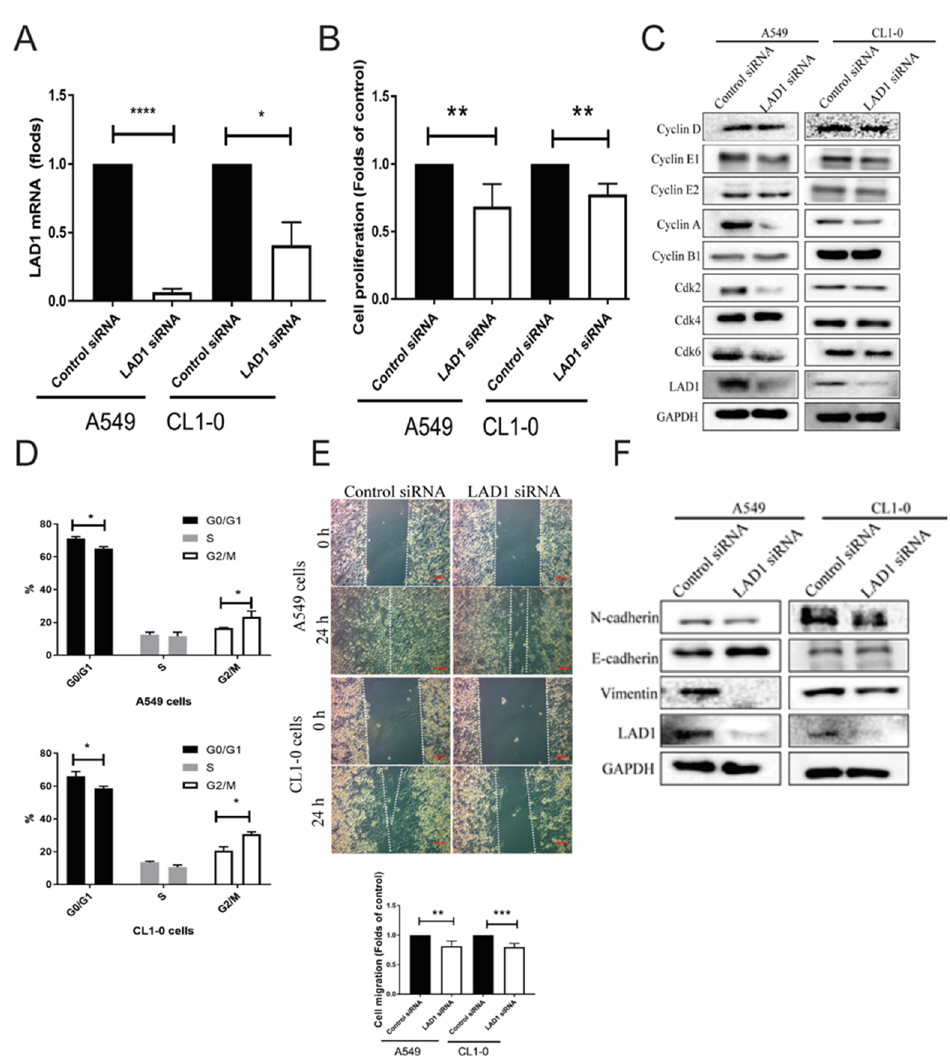
Figure 7. Functional analysis of LAD1 in LUAD. ( A ) Knockdown efficiency of LAD1 via siRNA method. ( B ) Cell proliferation is counted when LAD1 expression was downregulated with in A549 and CL1-0 LUAD cancer cell lines. ( C ) Cell cycle associated proteins are analyzed by Western blot. ( D ) Cell cycle analysis using a flow cytometry. ( E ) Cell migration in LAD1 knockdown A549 and CL1-0 cell line is assessed by wound-healing assay. ( F ) Epithelial mesenchymal transition (EMT) markers are also evaluated with Western blot. Both A549 and CL1-0 LUAD cancer cell lines are transfected with control siRNA or LAD1 siRNA. All experiments were performed independently at least three times. (*, p < 0.05; **, p < 0.01; ***, p < 0.005; ****, p <